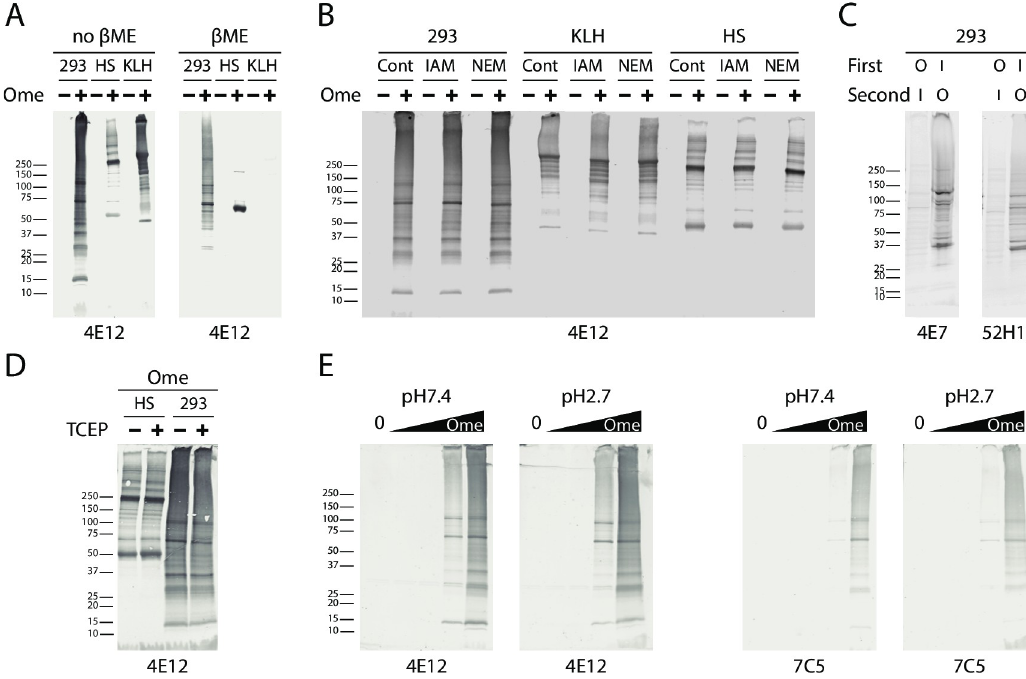
Fig 3. Role of redox state, cysteine residues, and pH in the formation of Ome-protein complexes. (A) Western blot analysis with 4E12 antibody, performed on non-reduced (left) and reduced (right) proteins (proteins in PBS co-incubated with 2mM omeprazole for 2 hours at 37˚C), indicates that β ME did not fully eliminate many of the protein omeprazole complexes. This was most noted with HEK293 lysates (293) and human serum (HS) proteins, implicating involvement of non-cysteine residues in bonding interactions. Ome-KLH, however, showed marked sensitivity to β ME. Band quantification revealed 65%, 50%, and 95% of signal reduction was observed for HEK293, HS, and KLH Ome-protein complexes after treatment with β ME. (B) HEK293 lysates, KLH, and HS proteins were pre-incubated with vehicle (Cont) or 10mM IAM or NEM for 2 hours at 37˚C prior to reaction with 1mM omeprazole for 2 hours at 37˚C. All treatments failed to block the binding of omeprazole to proteins as detected by the 4E12 antibody (non-reducing condition for SDS-PAGE) which indicate that omeprazole binding does not require cysteine sulfhydryl residues. (C) Pre-incubation of 2mM omeprazole (O) to HEK293 lysates for 2hr at 37˚C followed by 2mM IAM (I) for 2 hours at 37˚C inhibited detection of carboxamidomethyl cysteine (CAM-cys) labeling of protein by antibodies, 4E7 (left) and 52H11 (right). The blockade of CAM-cys formation is consistent with omeprazole competition for sulfhydryl residues that normally react with IAM (proteins were reduced prior to SDS-PAGE). (D) Effect of pre-reduction of human serum proteins and HEK293 lysates by TCEP agarose of omeprazole labeling. TCEP pretreatment, compared with non-reduced proteins, labeled to same extent with omeprazole as shown by Westerns using 4E12 which indicates that omeprazole binding in these proteins involves interactions beyond disulfide bond formation (1mM omeprazole at 37˚C for 2 hours, non-reducing SDS-PAGE). (E) Effect of pH on omeprazole labeling of protein. A dose ramp of omeprazole (0, 0.001, 0.01, 0.1, 1mM omeprazole) with HEK293 lysates was conducted at pH7.4 and 2.7 at 37˚C (2 hour co-incubation). No significant differences between the two reaction groups indicate that omeprazole is able to react similarly at neutral and acidic conditions (non-reducing SDS-PAGE). All the samples (A-E) were boiled for 3 minutes in sample buffer prior to analysis. In a separate analysis, we determined that sample boiling before addition of omeprazole reduced Ome-protein complex detection (S1